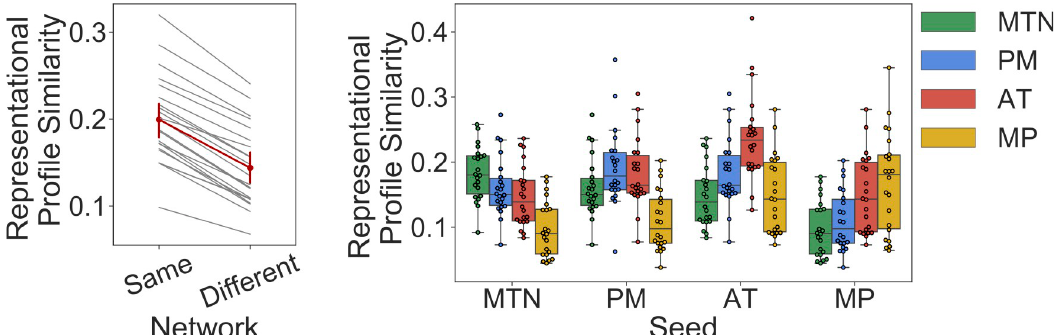
Fig 6. Regions show higher representational profile similarity with community members compared to regions in other communities. Left: individual subject representational profile similarity of regions within the same network or between network in gray lines with the group average in red, with 95% confidence intervals represented by error bars. Right: boxplot of average region- to-region representational profile similarity between each cortical-hippocampal network (labeled along the x-axis) to itself and every other cortico-hippocampal network (each represented by a colored bar) across the sample (see S6 Fig for the representational profile similarity of the cortico-hippocampal networks compared to every other cortical network). Individual participants represented as dots. AT, anterior temporal; MP, medial prefrontal; MTN, medial temporal network; PM, posterior medial. Data can be found at https://github.com/ajbarn/hippo_nets.